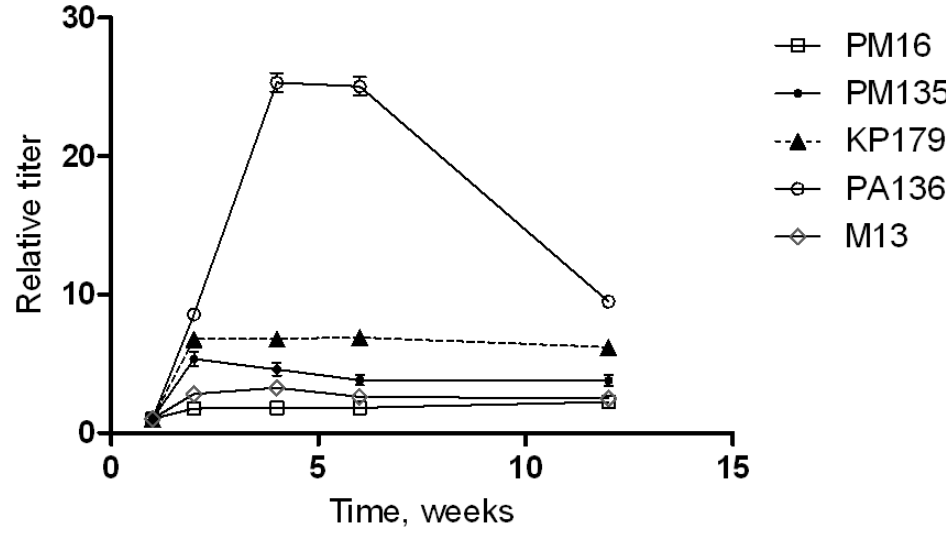
Figure 4. Phage-specific indirect ELISA of sera of immunized mice. Serum samples were obtained before immunization and 1, 2, 4, 6, and 12 weeks after the last immunization of mice injected three times with a selected phage (PM16, PM135, KP179, PA136, or M13) without any adjuvants. Antibody titers were calculated based on the crossing of dilution curves with the baseline. Results are given as relative antibody titers, calculated as a ratio of different time point titers to the initial titer (before immunization) of antibodies against the corresponding phage.